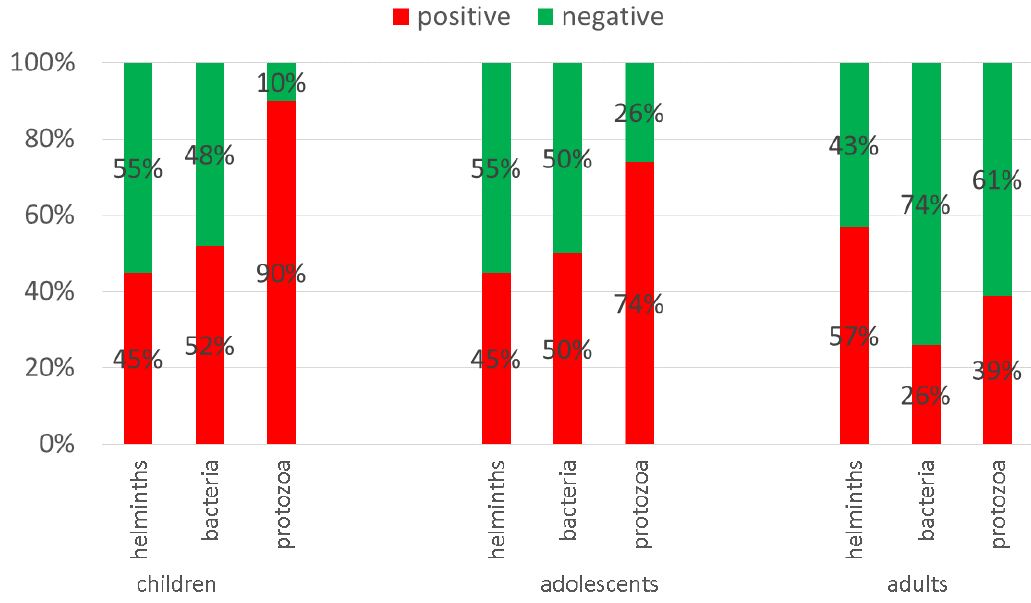
Figure 3. Type of parasite per age group ( n = type of parasite based on at least one positive detection).